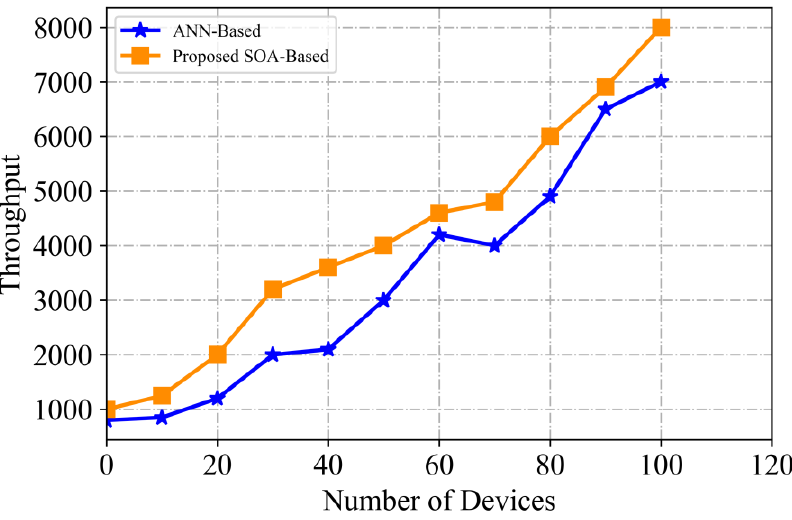
Figure 9. Comparative analysis of throughput.